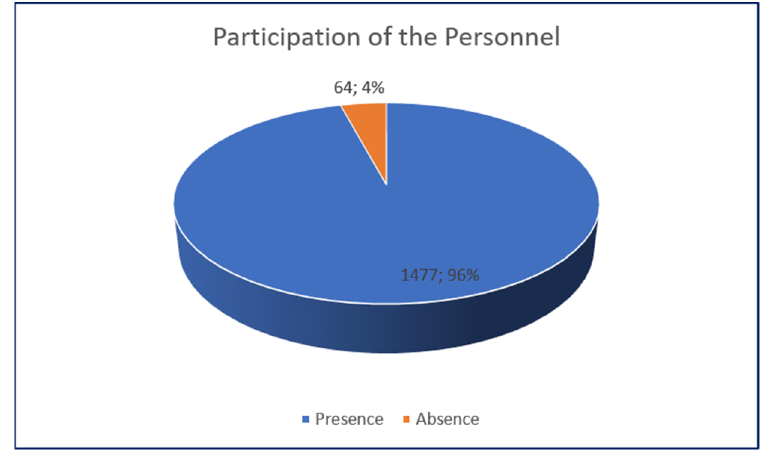
Figure 7. Participation of the personnel during the Anointings.